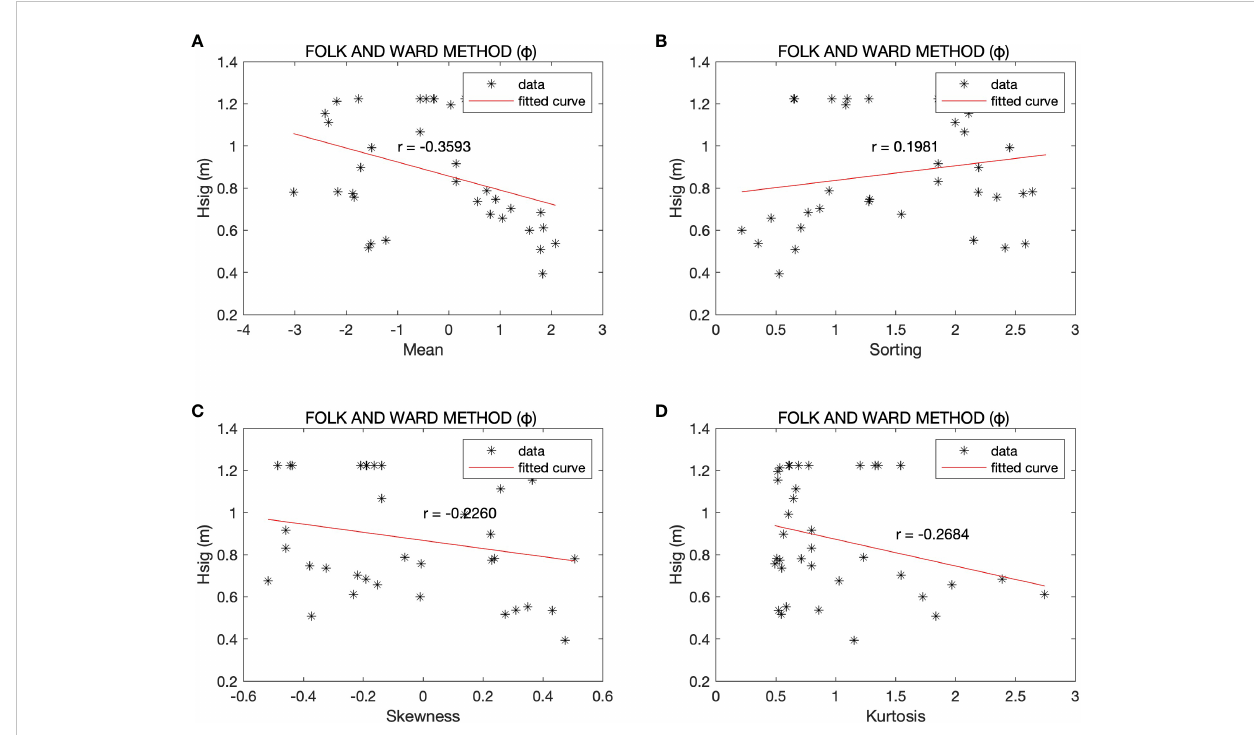
FIGURE 9 Correlation between H s and sediment properties: (A) Mean, (B) Sorting, (C) Skewness, (D) Kurtosis of seabed sediment samples.